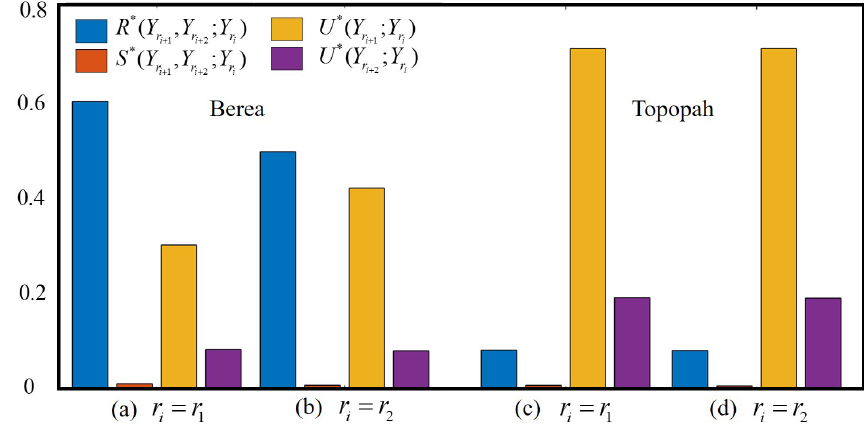
) , considering two triplets of data and r i = (a) r 1 , Y r ; Y r i i + 1 i + 2 ) , Y r ; Y r i i + 1 i + 2